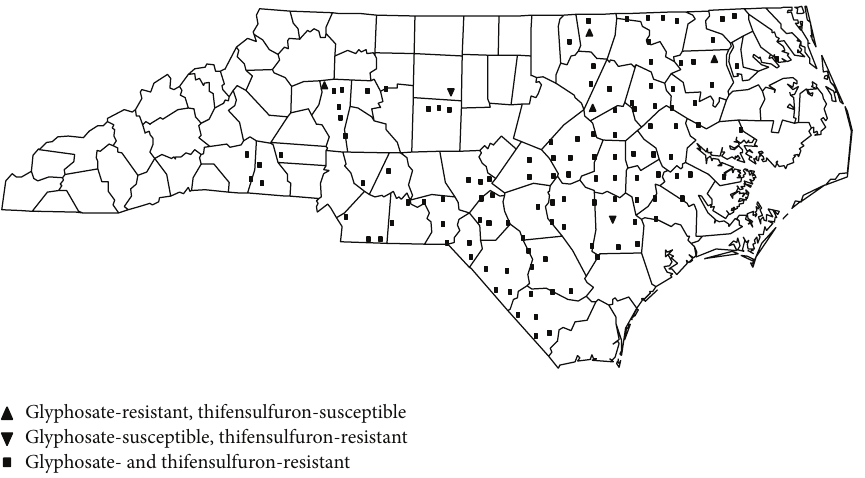
Figure 3: Distribution of glyphosate- and thifensulfuron-resistant Palmer amaranth in 2010.